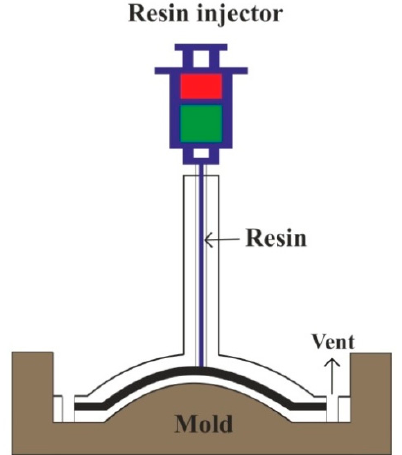
Figure 6. Resin transfer molding process.